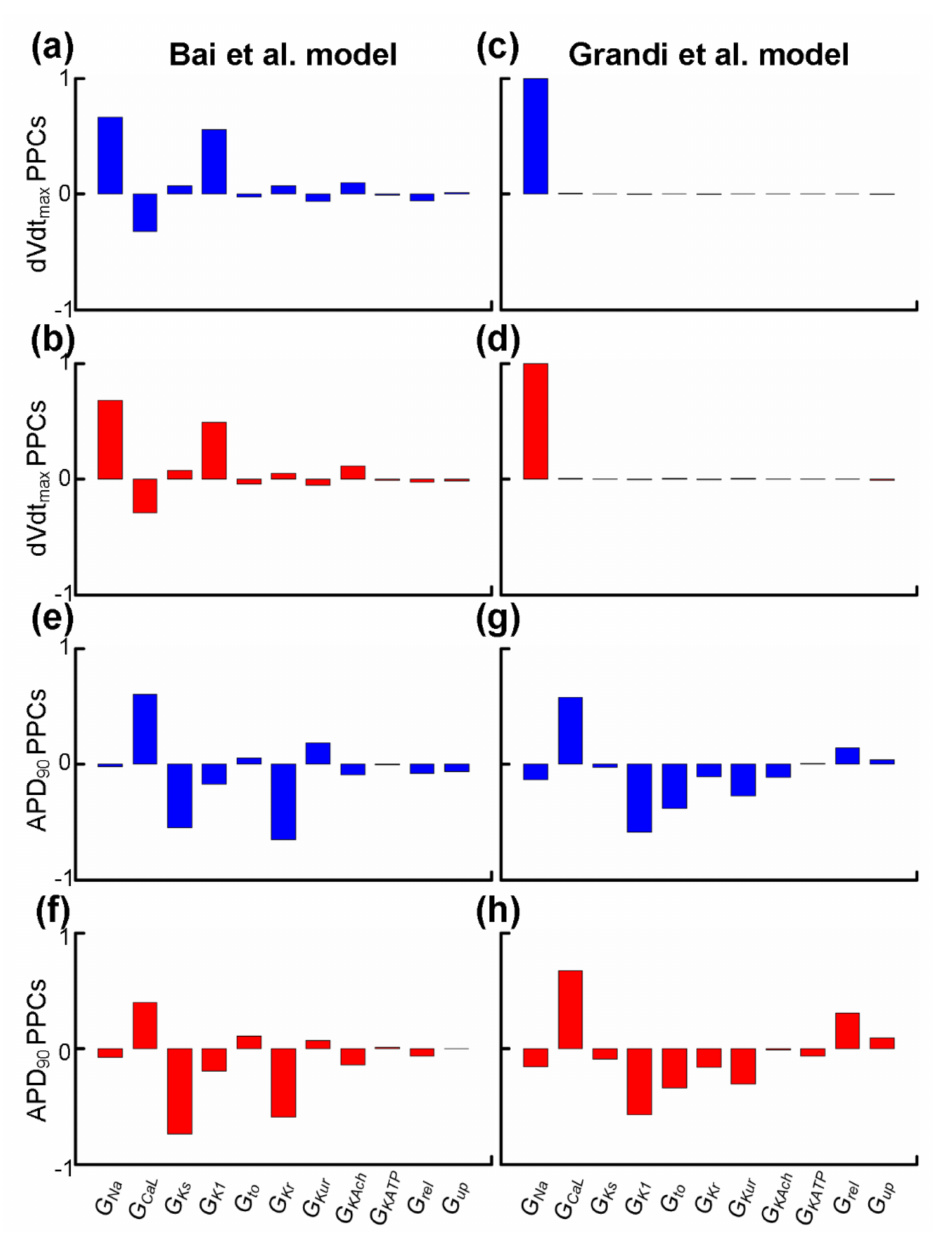
Figure 4. Partial correlation coefficients (PPCs) between biomarkers (dVdt max or APD 90 ) and param- eters associated with Pitx2 -induced electrical remodelling (G Na , G CaL , G Ks , G K1 , G rel , and G up ) or actions (G Na , G CaL , G to , G Ks , G Kr , G Kur , G KATP , G KAch,Ado , and G K1 ) of antiarrhythmic drugs. PPCs between dVdt max and G Na , G CaL , G Ks , G K1 , G Kr , G to , G Kur , G KATP, G KAch,Ado , G rel , or G up for the virtual atrial myocytes created by the Bai et al. model in SR ( a , blue) and AF ( b , red) are compared to those for virtual atrial myocytes in the SR ( c , blue) and AF ( d , red) populations created by the Grandi et al. model. PPCs of APD 90 for virtual atrial SR ( e , blue) and AF ( f , red) myocyte populations created by the Bai et al. model are compared to those for the virtual atrial myocytes created by the Grandi et al. model in SR ( g , blue) and AF ( h ,